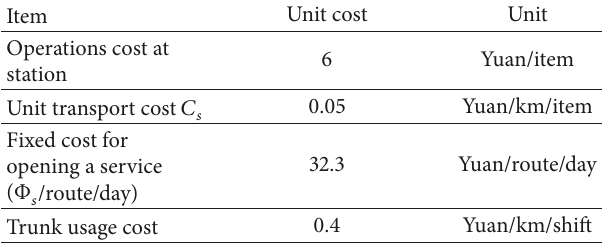
Table 7: Cost parameters in the case